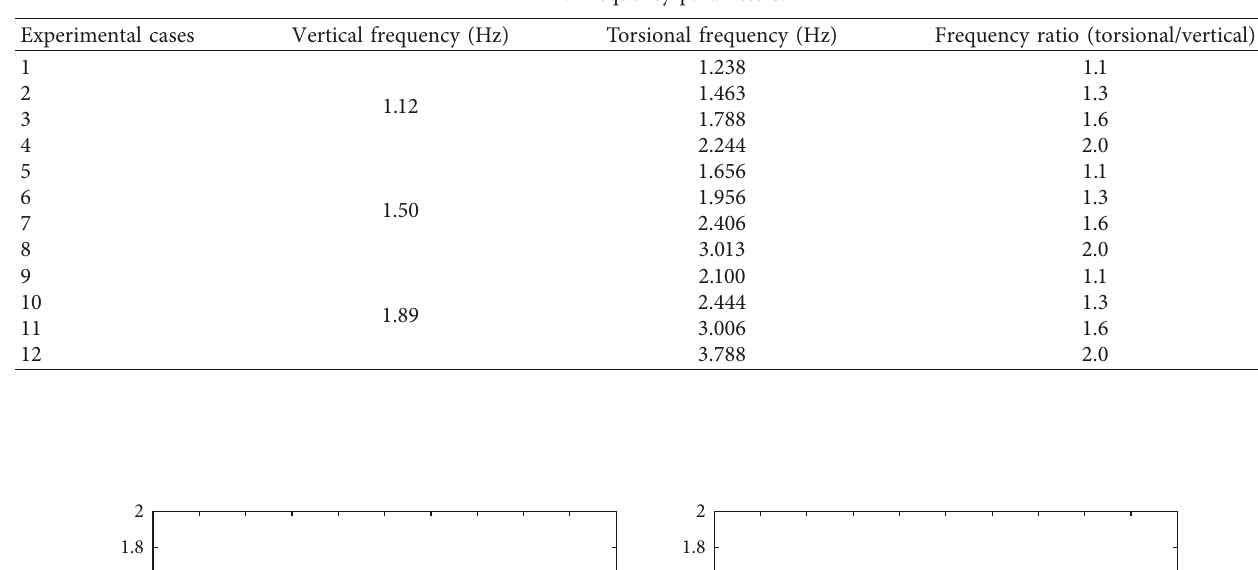
Table 2: Frequency parameters.